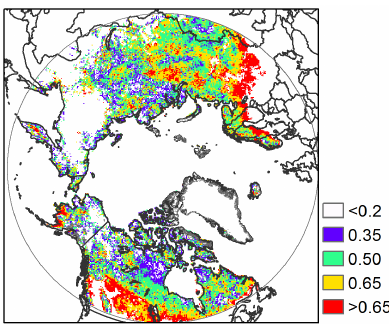
Figure 10. The correlation coefficient between number of melt days and the duration of winter period from PMW during 1988–2013. Correlations greater than 0.35 are statistically significant at 90% confidence level.